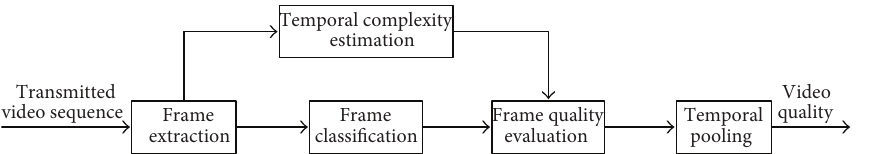
Figure 2: Framework of the proposed video quality assessment